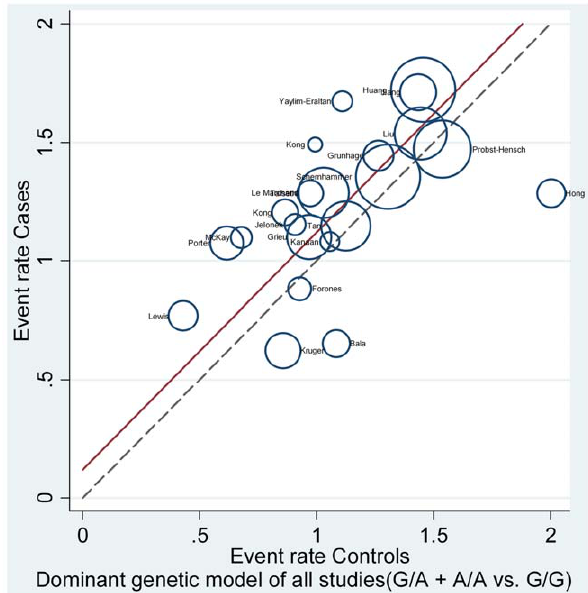
Figure 3. The L’Abbe´ plot [ 14 ] for the assessment of CRC risk in each group (G/A + A/A vs. G/G). Each circle represents individual trial sizes, and the circles are proportional to the study weights (participant number). The diagonal dotted line indicates that the CRC risk was equal in the two arms within the trials. The solid regression line represented a summary OR of 1.127 (G/A + A/A vs. G/G), which was estimated from the